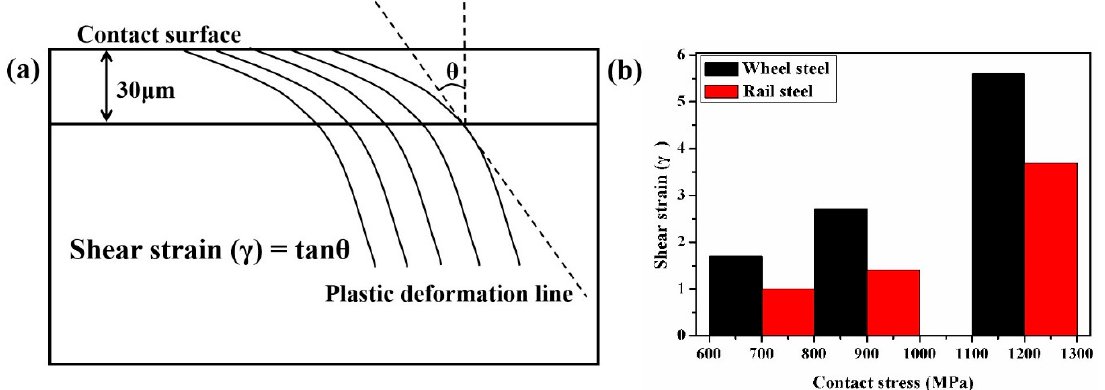
Figure 14. The variation of the shear strain of wheel and rail samples. ( a ) The schematic diagram of the shear strain measurement technique [28] and ( b ) the variation of shear strain values.